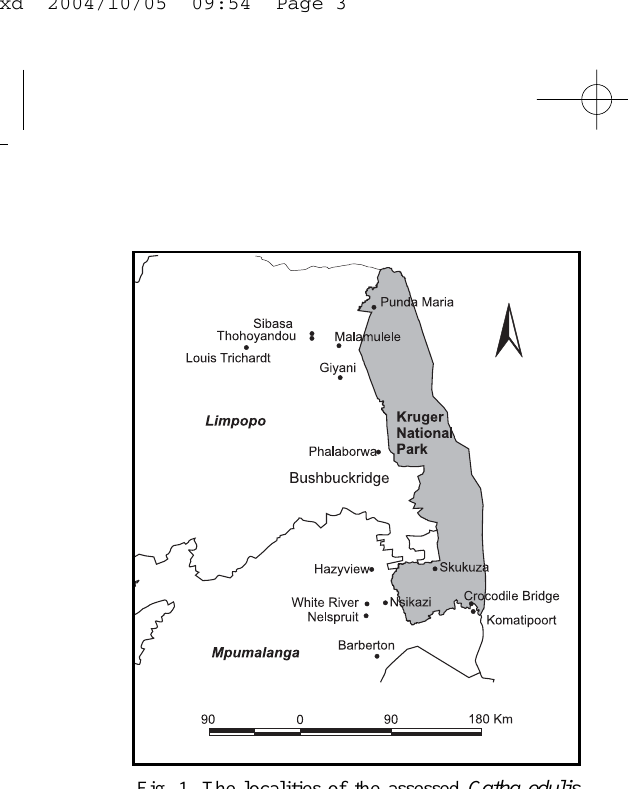
Fig. 1. The localities of the assessed Catha edulis and Rapanea melanophloeos